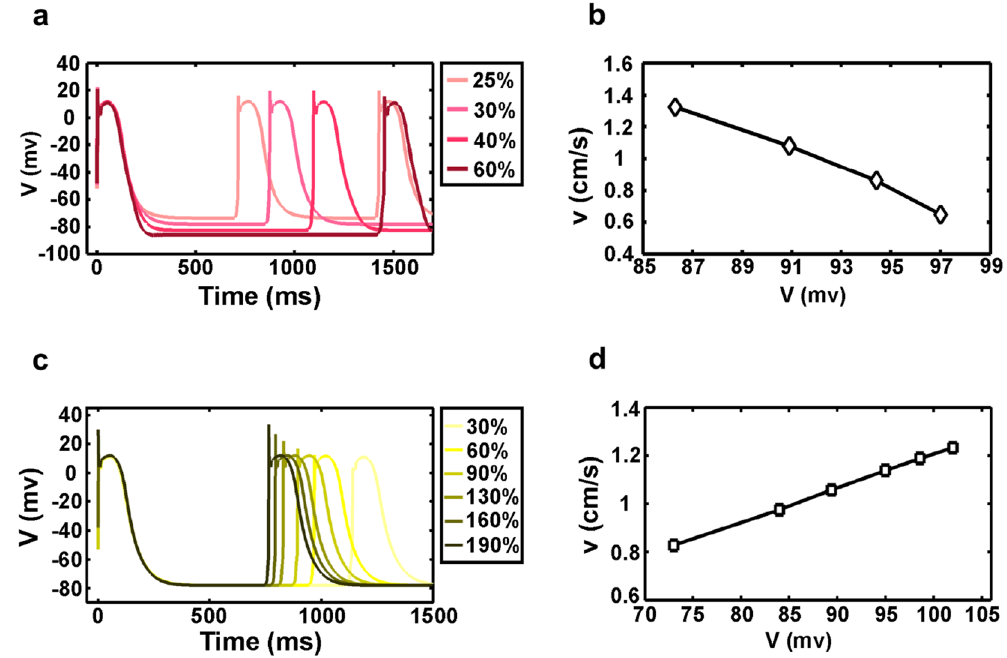
Figure 6. Membrane potential difference directly affects traveling wave speed under no hyperpolarization- activated current conditions. ( a ) Single cell membrane potential curves of different I K1 . ( b ) Increased potential difference caused by I K1 leads to lower wave speed. ( c ) Single-cell membrane potential curves under different I Na conditions. ( d ) Increased potential differences caused by I Na leads to higher wave speed. ( a – d :